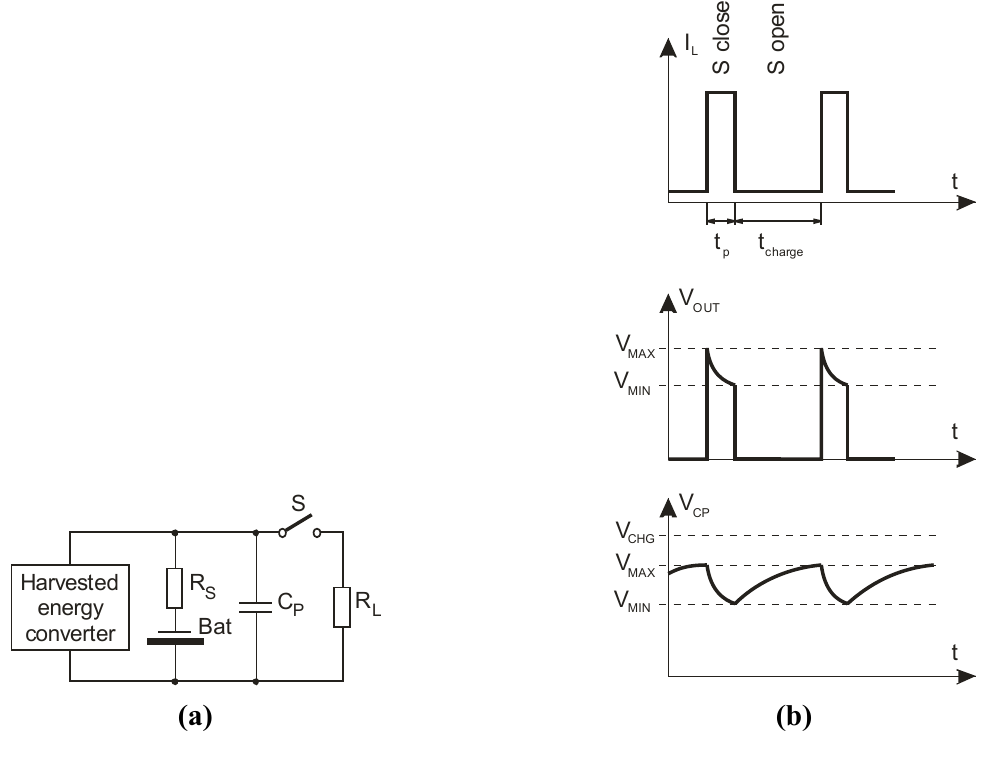
Table 2. Energy-harvesting estimates (as reported in